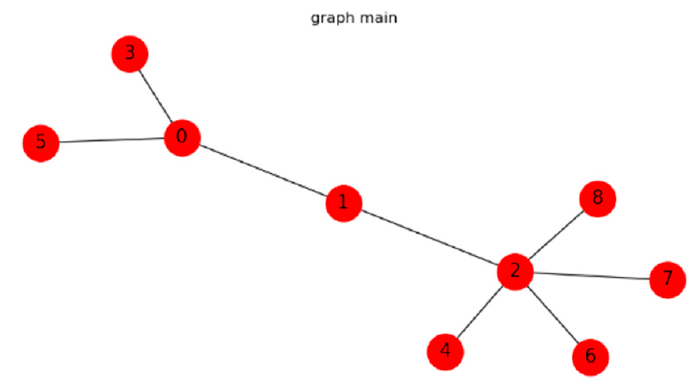
Figure 4. The collaborative design crowdsourcing task network graph.